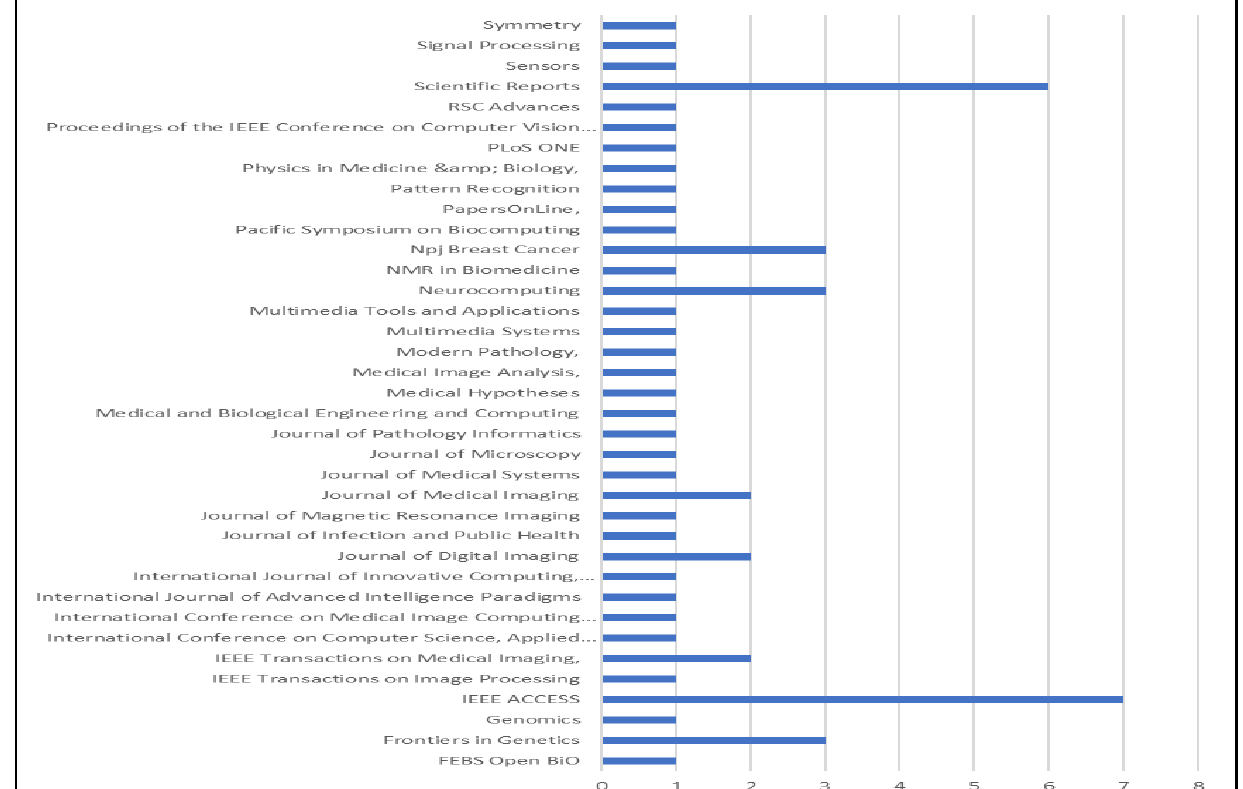
Figure 10. Number of articles per journal.